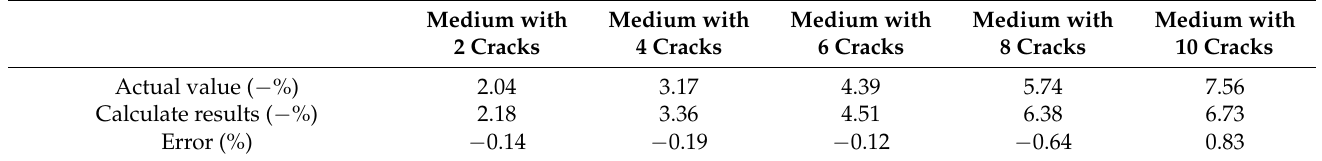
Table 2. The actual and calculated wave velocity change rate calculated with the CWI method.